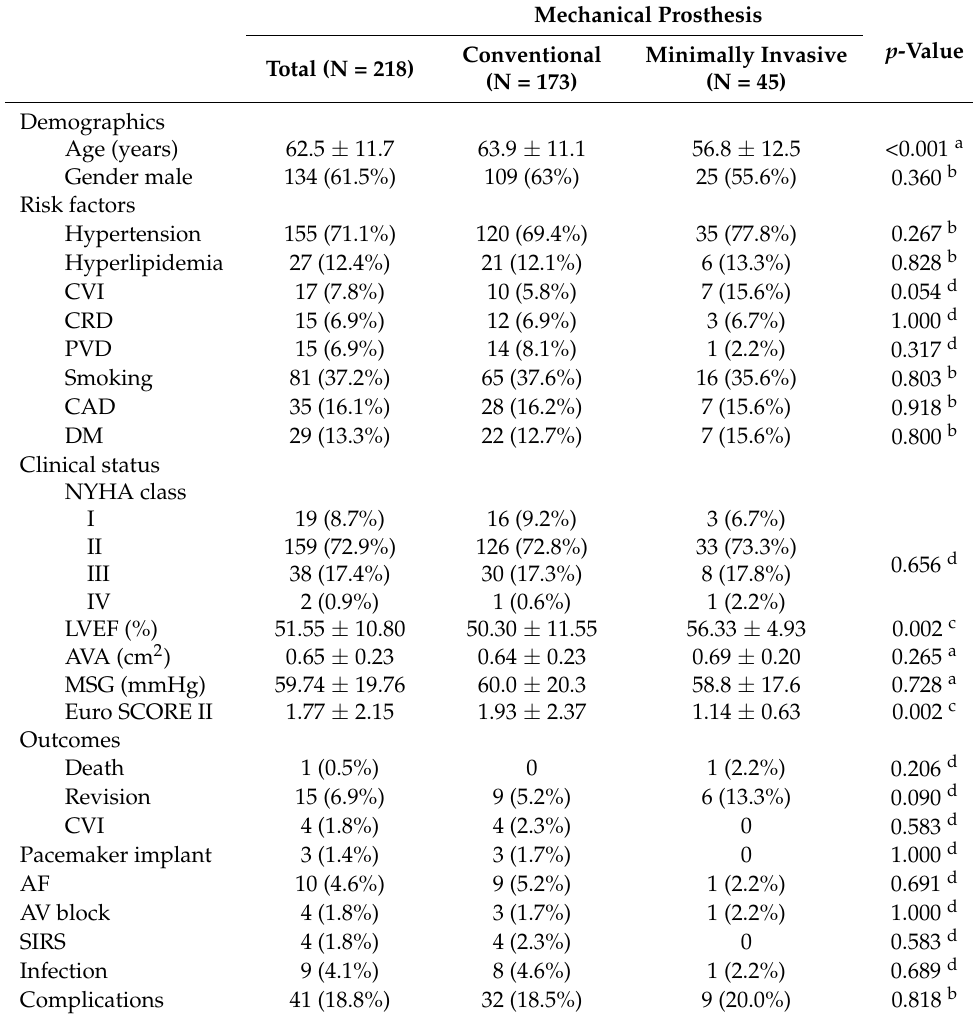
Table 2. Preoperative characteristics, clinical status, and the most important clinical outcomes of conventional and minimally invasive AVR patients with mechanical